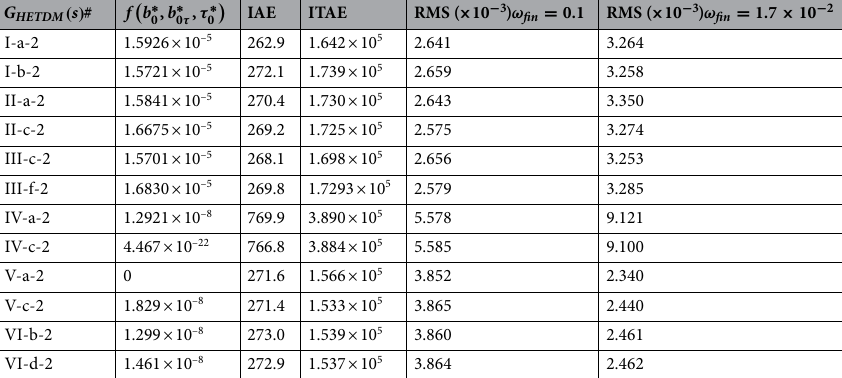
Table 10. HETDM time-domain and frequency-domain model errors (ad Table 9).